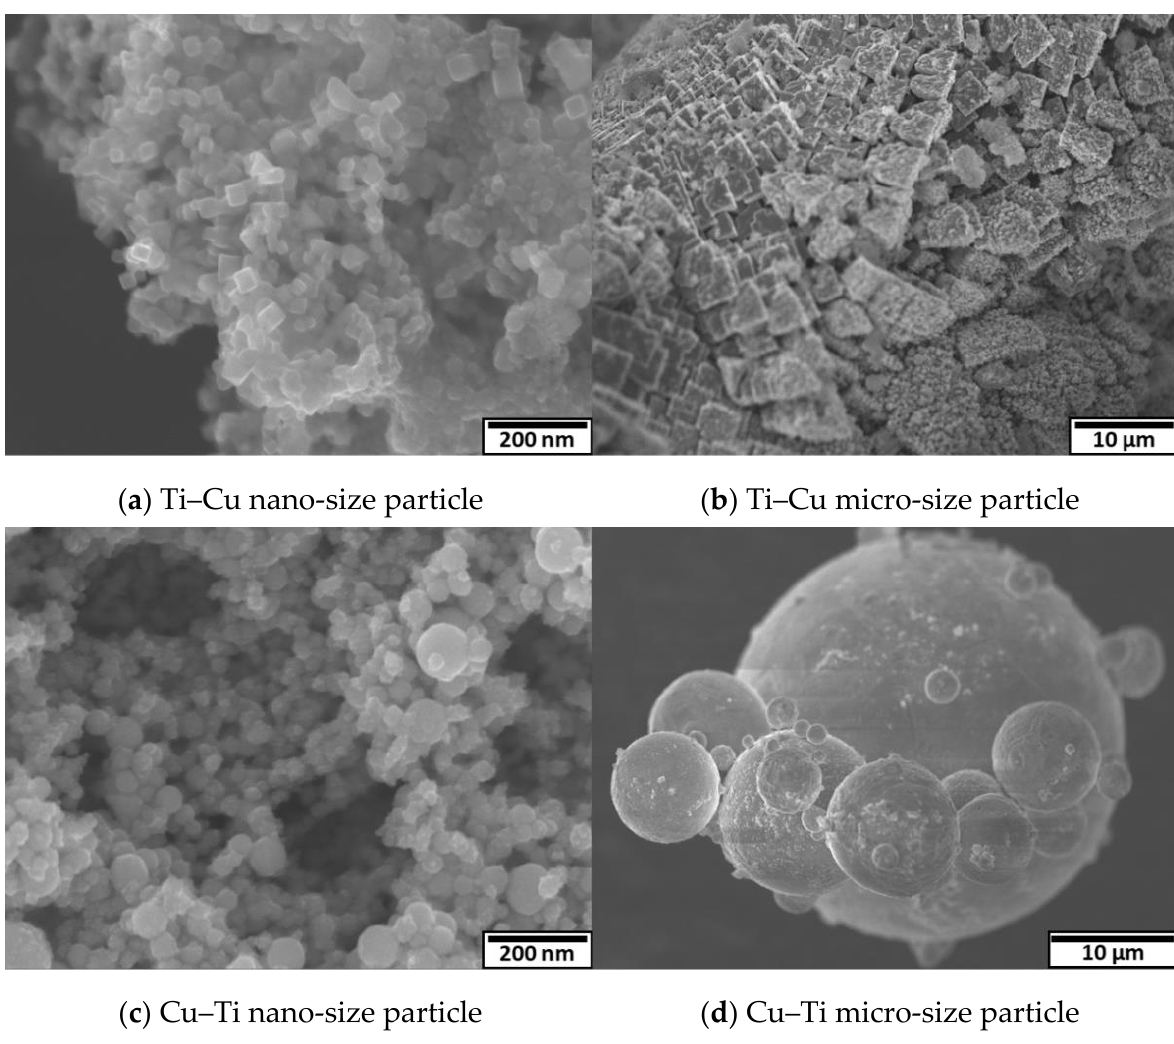
Figure 14. Morphologies of the prepared particles. ( a ) Ti–Cu nano-size particle, ( b ) Ti–Cu micro-size particle, ( c ) Cu–Ti nano-size particle, and ( d ) Cu–Ti micro-size particle.